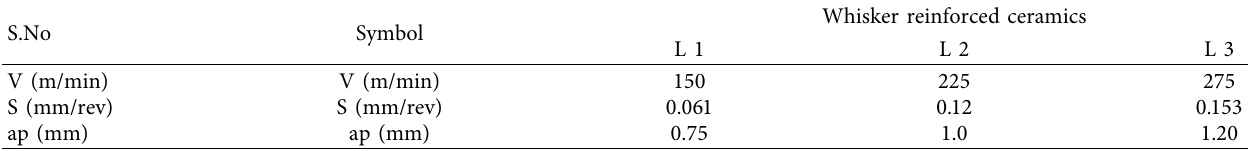
Table 1: Machining